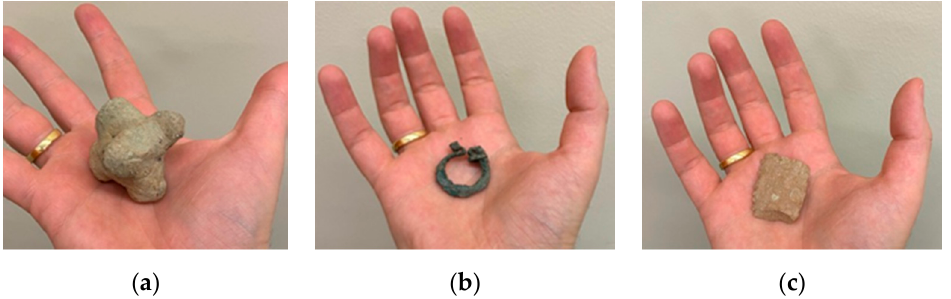
Figure 2. Archaeological specimens: ( a ) separator; ( b ) brooch; and ( c ) racloir.